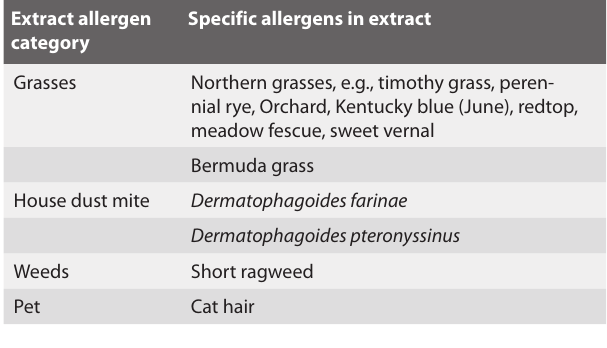
Table 3. Standardized allergen extracts available in the United States. Extract allergen